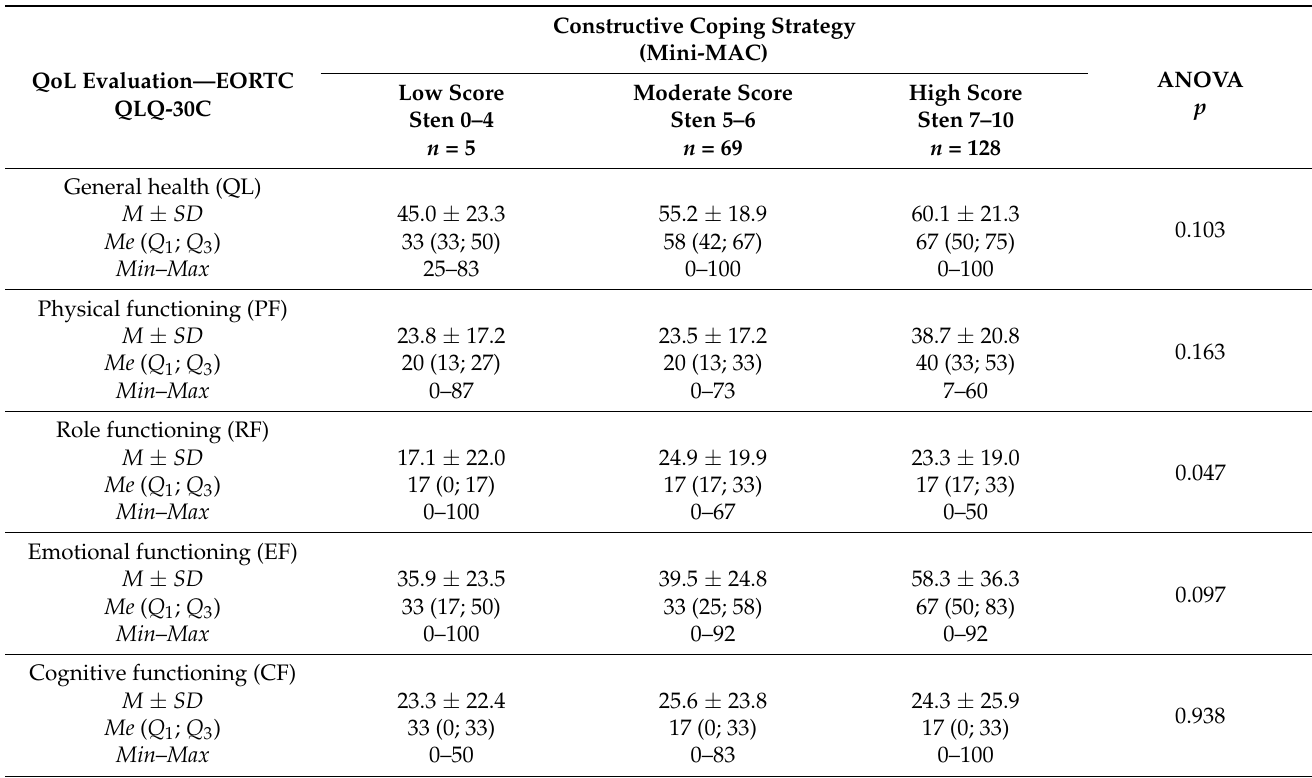
Table 5. Quality of life (EORTC QLQ-30C scores) in patients differing in terms of scores for the constructive coping strategy (Mini-MAC), with analysis of variance